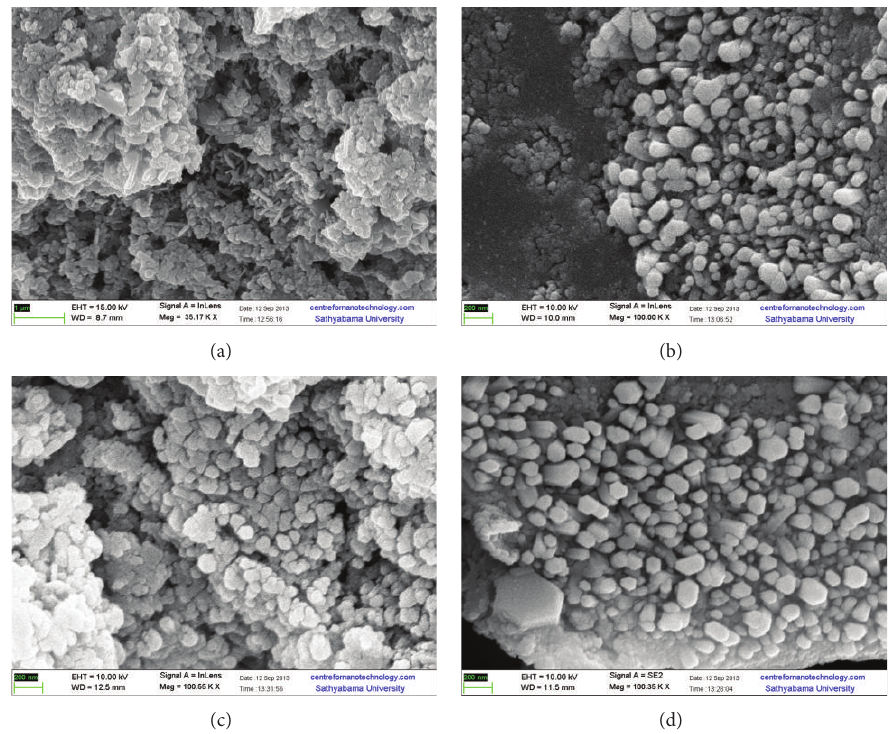
Figure 2: Surface morphology (FESEM) of (K (1%), Fe) codoped ZnO for Fe concentrations: (a) 1%, (b) 2%, (c) 3%, and (d) 4%.